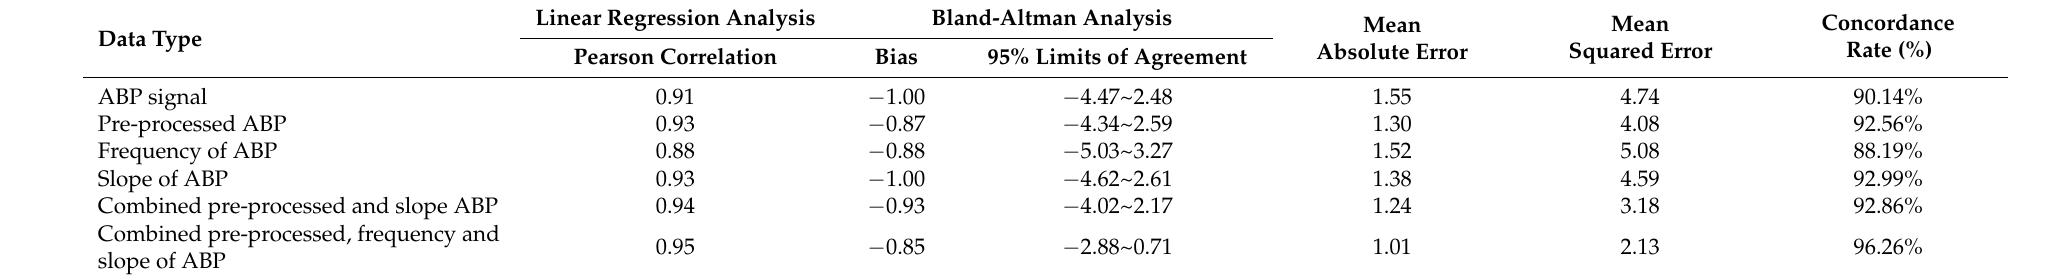
Table 4. Trend analysis of various pre-processing input